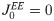
The two mechanisms for asynchronous chaos in two-population LIF spiking and rate networks.Simulations were performed with N
E = N
I = 16000, K = 400, I
E = 0.2, I
I = 0.1, J0EE=0, J0EI=0.8, J0IE=3. A: II mechanism. PACs of the net inputs in E neurons are plotted for J0II=4, τ
IE = 100 ms, τ
EI = 3 ms and τ
II = 3, (red), 10 (black), 40 (blue) and 100 ms (purple). Solid line: Spiking model. Dots: Rate model. Inset: All PACs (spiking network) are plotted vs. τ/τ
II. B: Voltage of one E neuron for parameters as in A, purple. C: EIE mechanism. PACs of the net inputs in E neurons are plotted for J0II=1, τ
EI = τ
II = 3 ms and τ
IE = 100, (green), 200 (red) and 400 ms (black). Solid line: Spiking model. Dots: Rate model. Inset: All PACs (spiking network) are plotted vs. τ/τ
IE. D: Voltage of one E neuron in the spiking network with parameters as in C, green.